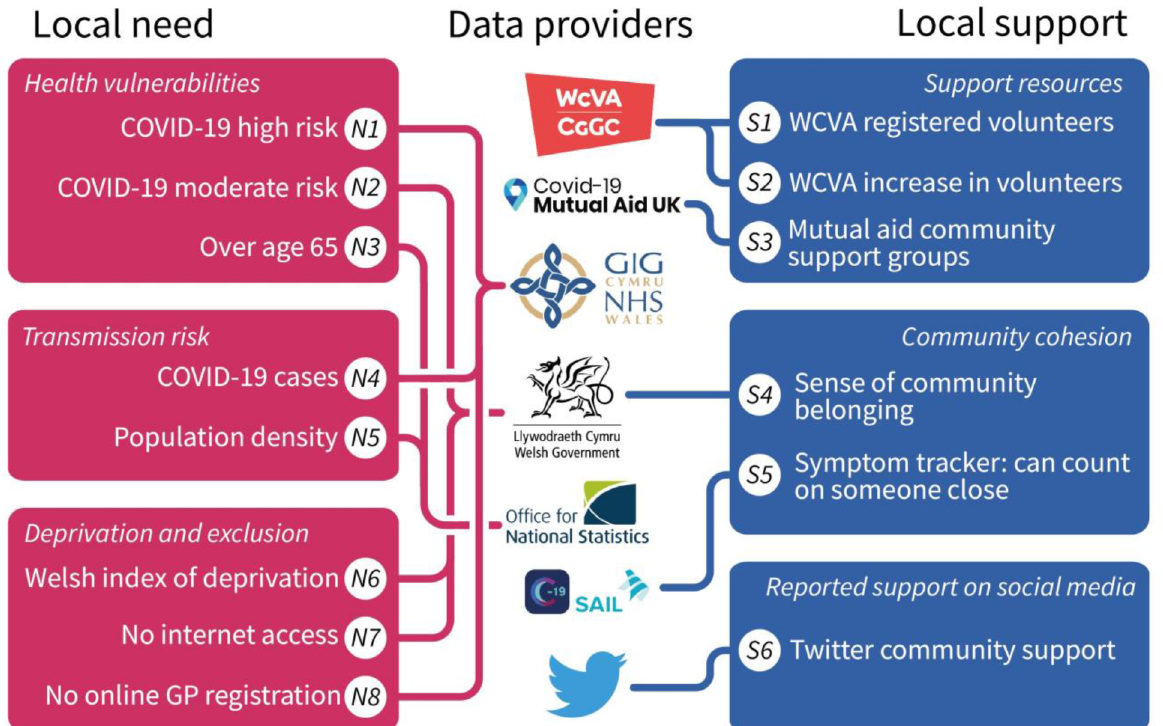
Table 1: Summary description of variables included in the health and vulnerabilities dataset